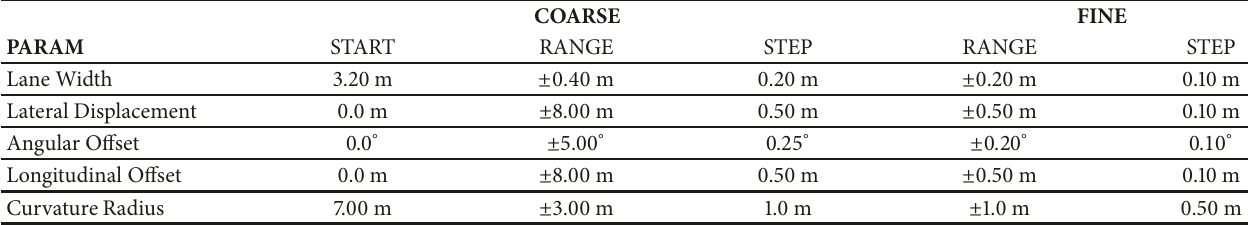
Table 1: Model parameter range of values.